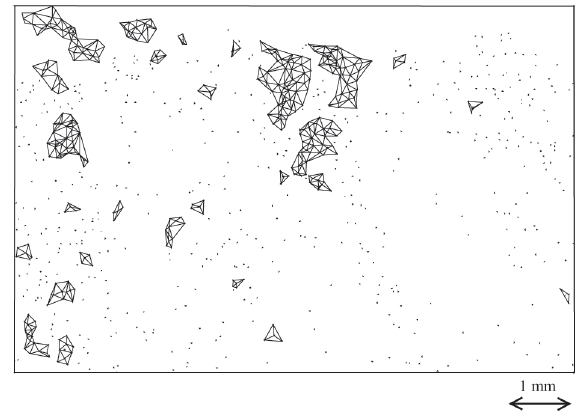
Figure 5. Crack map of a F20 (aged 10 4 h at 400 °C) specimen. Cracks are located at dots and at the vertices of triangles. Trian- gles show crack clusters from Voronoï